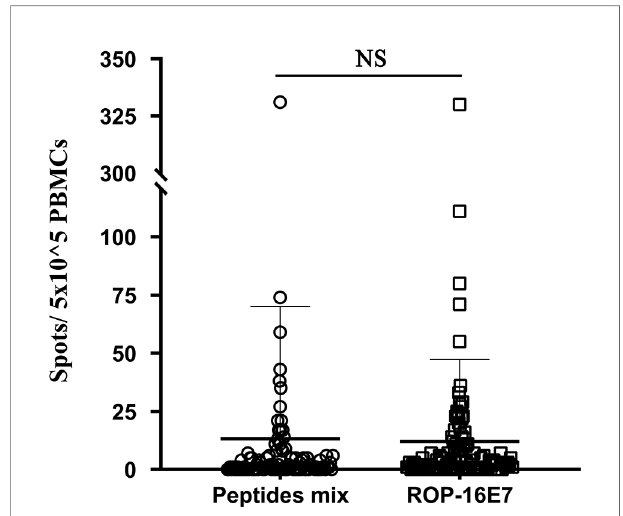
FIGURE 1 | IFN- g release assay of patient-derived PBMC cultures that recognize HPV16-speci fi c peptide pools (peptides mix) and ROP-16 E7. NS, no signi fi